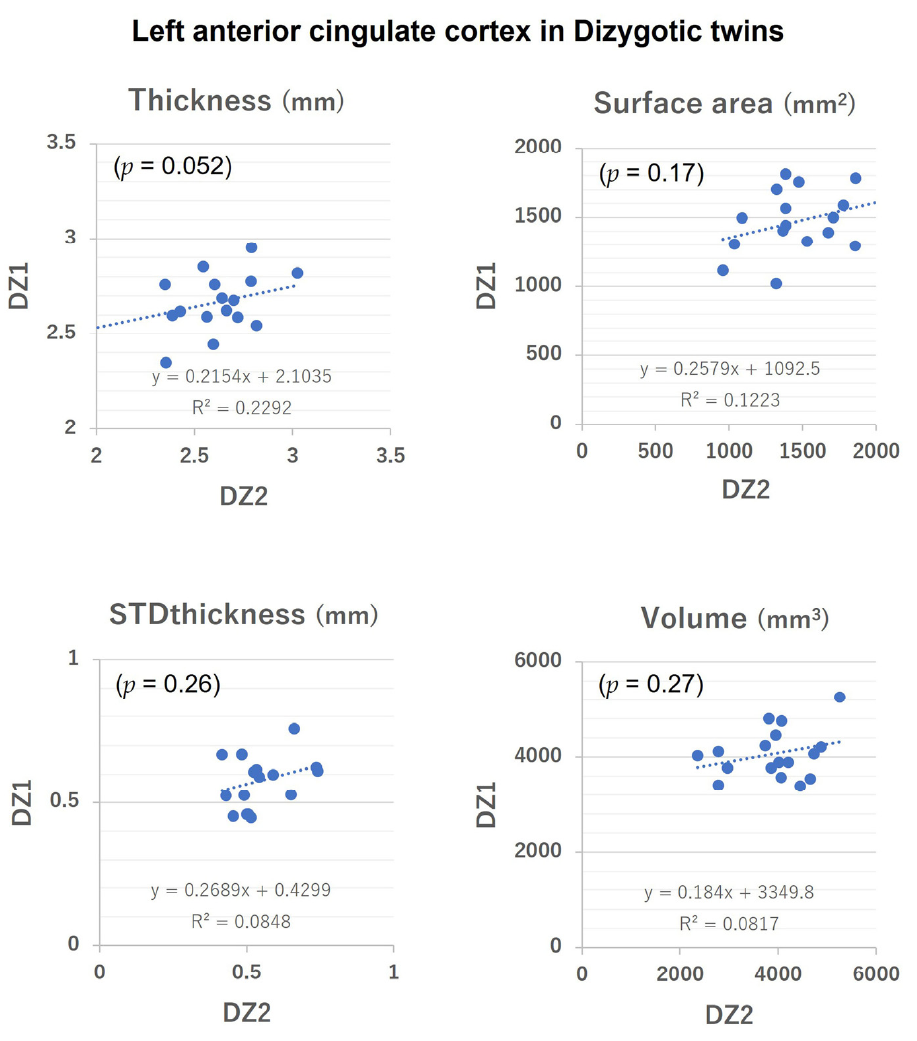
Figure 3. Intra-twin pair correlation of surface morphological parameter values (Thickness, Surface area, STDthickness, and Volume) of the left anterior cingulate cortex in dizygotic twins. STDthickness: standard deviation of the